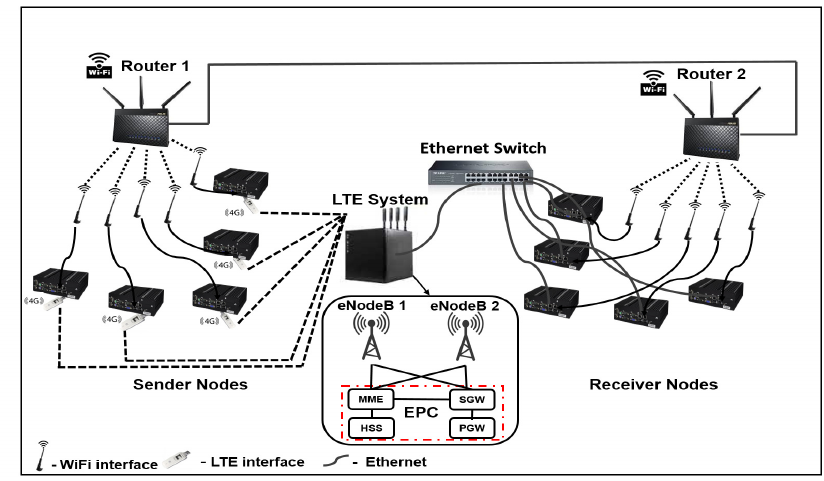
Figure 1. Testbed Setup 1.